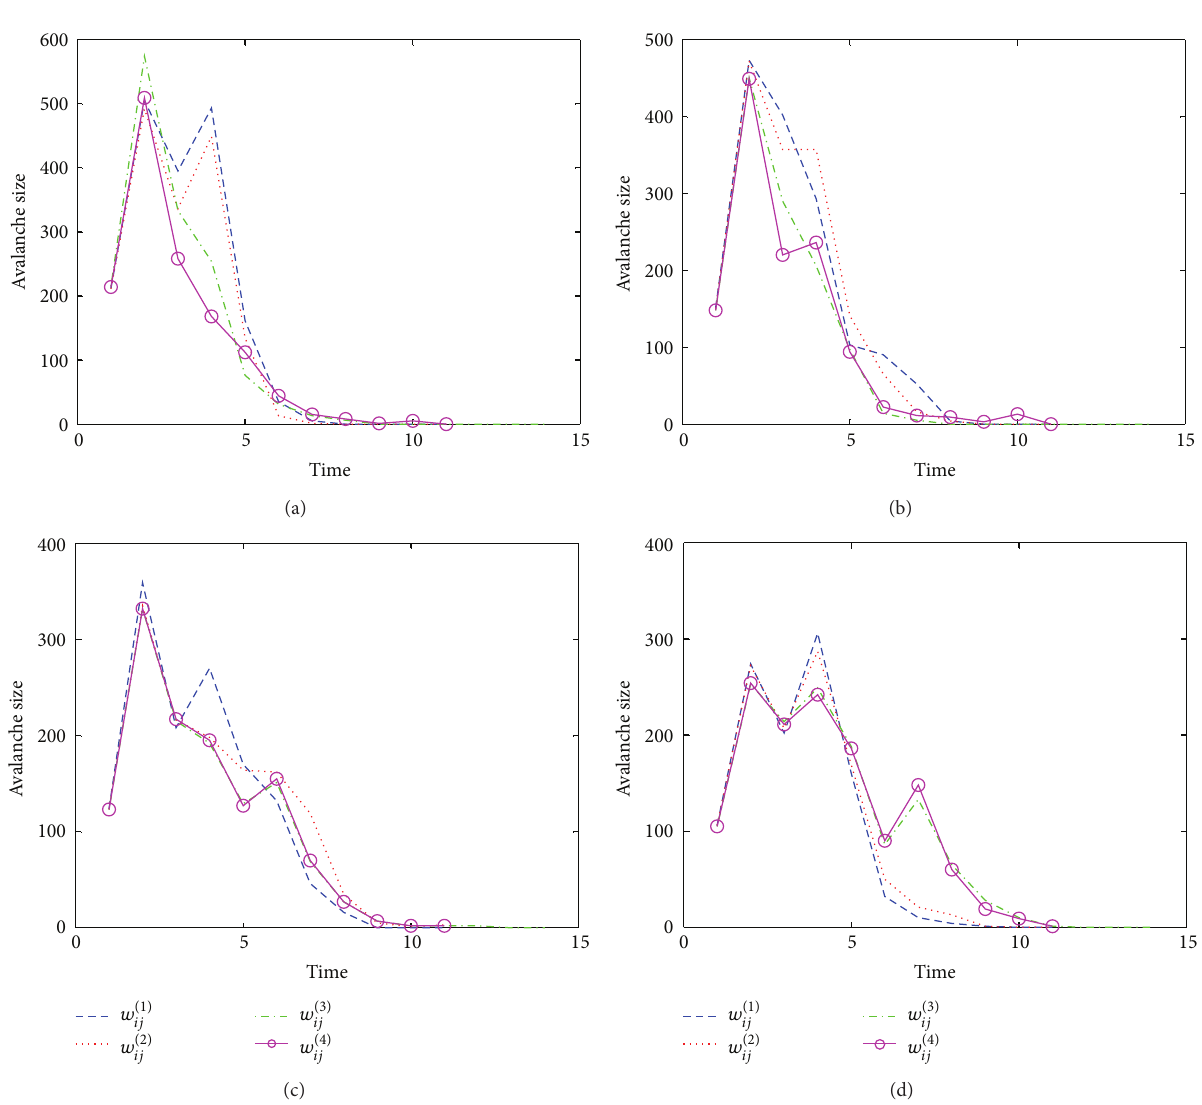
Figure 8: For autonomous system network with 𝜏 = 20 under HL attack, the avalanche size 𝑁 (a) 𝛼 = 0.02 , (b) 𝛼 = 0.04 , (c) 𝛼 = 0.06 , and (d) 𝛼 = 0.08 ,